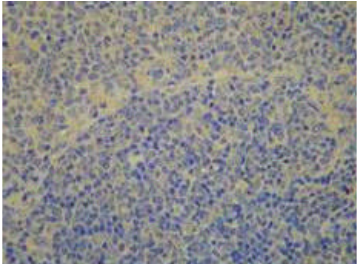
Figure 9: Treated group—21 d in OJ experiment (+) spleen, Bax ×